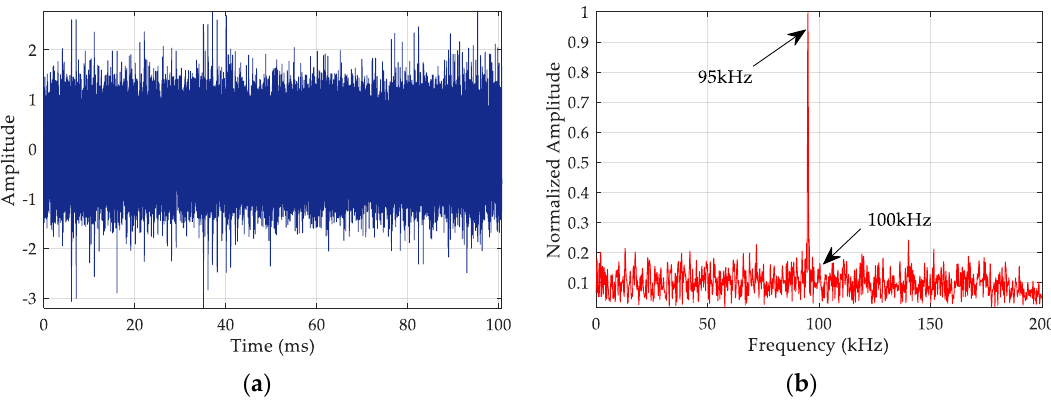
Figure 8. Characteristics of simulated signals: ( a ) signal waveform; ( b ) signal spectrum.